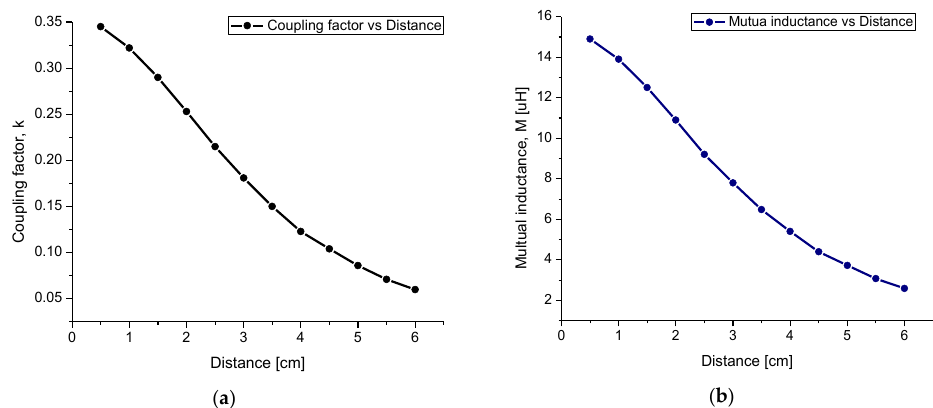
Figure 6. The relationship of both parameters: ( a ) the coupling factor and ( b ) the mutual inductance as a function of distance separation between the two coils.